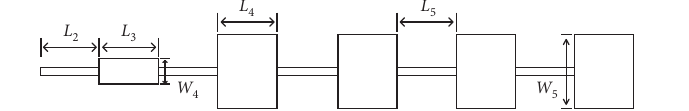
Figure 2: Dimension of linear array antenna.